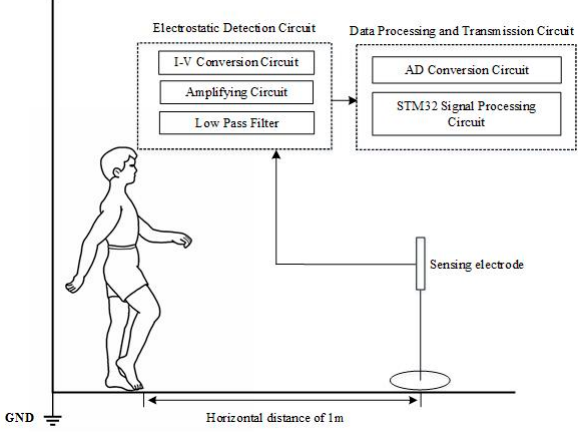
Figure 2. Schematic of the electrostatic sensing system .